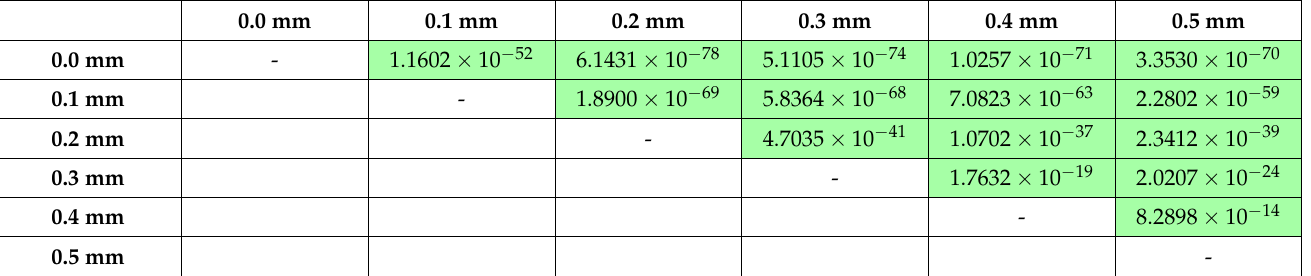
Table 1. p -values obtained by a sign test for all wood images. Green cells are those that have a statistically significant difference. The threshold used in the Bonferroni correction is 0.05/15 = 0.0033.